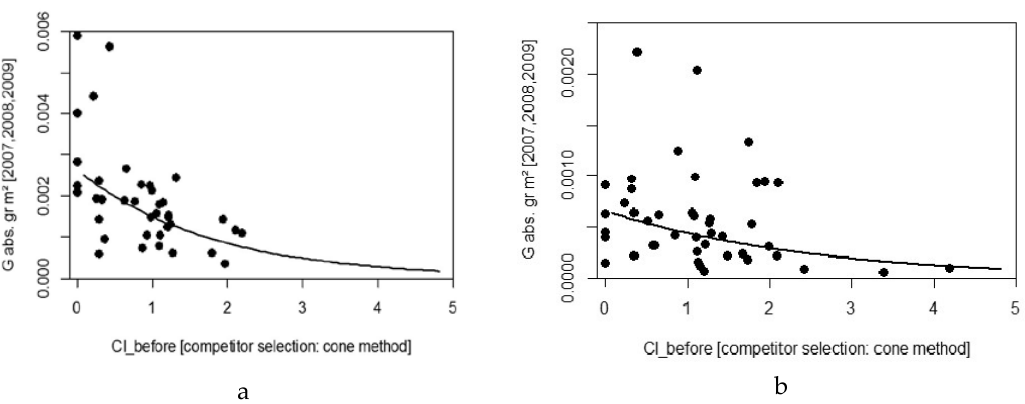
Figure 7. ( a ) Relationship between competition index (CI_before) and basal area growth (2007 to 2009) of larch prior to thinning: R 2 = 0.3257, p < 0.05. ( b ) Relationship between competition index (CI_before) and basal area growth (2007 to 2009) of birch prior to thinning:: R 2 = 0.1695, p < 0.05.